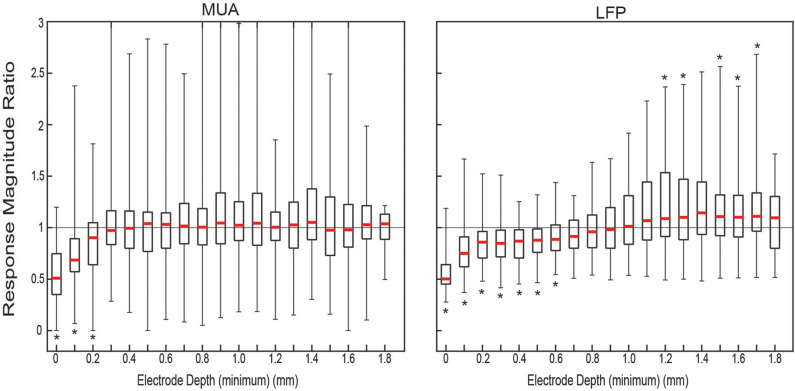
Measured ratio of evoked responses between conditions. Distributions of response magnitude ratio of all condition-pair sets of trials (n = 43). For each approximate electrode depth all the pairs (gray) and the quartiles (black) and median (red) of the distribution were plotted. Location of * denotes the median is significantly (p < 0.05) above (top) or below (bottom) 1.0.